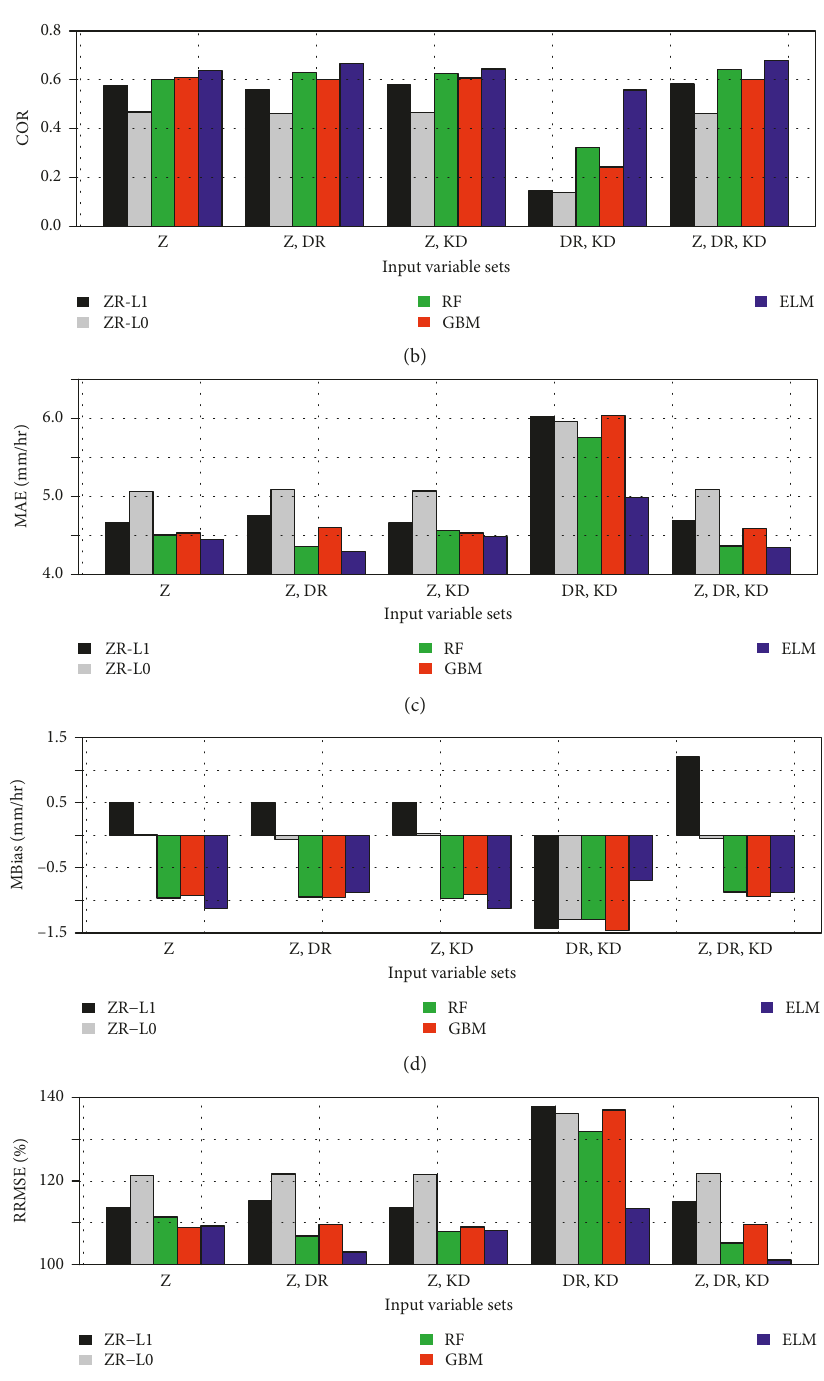
Figure 3: (a) Root-mean-square error (RMSE), (b) correlation (COR), (c) mean absolute error (MAE), (d) mean bias (Mbias), and (e) relative RMSE (RRMSE) of rainfall rate estimations by the tested quantitative precipitation estimation models for all rainfall events